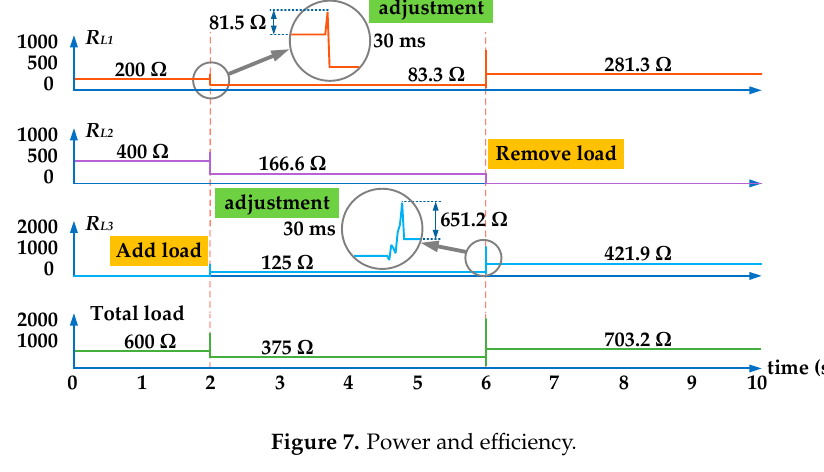
Figure 6. Comparative results.